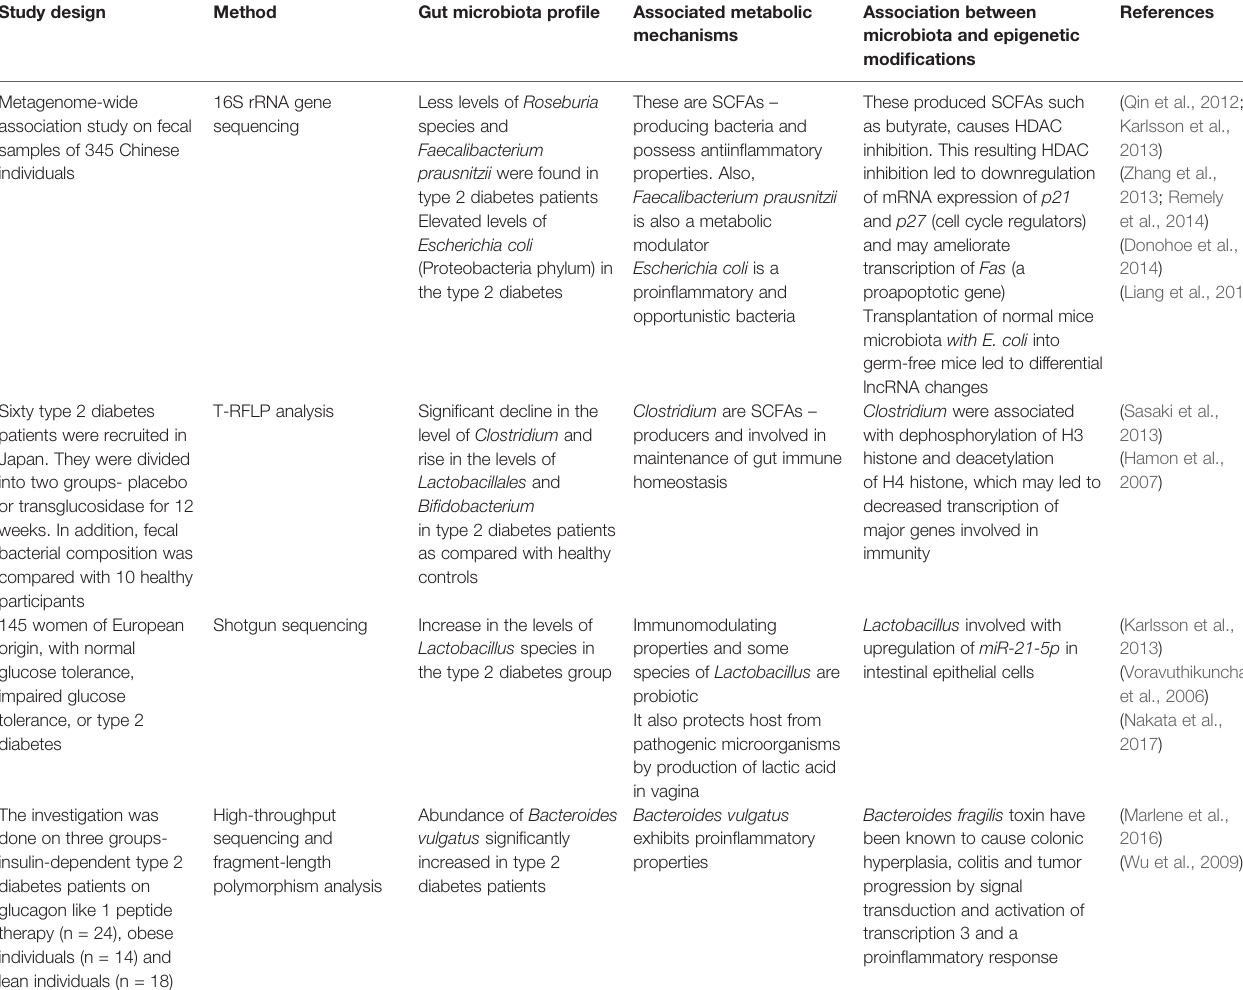
TABLE 3 | Interplay between gut microbiota, metabolic mechanisms, epigenetic modi fi cations, and type 2